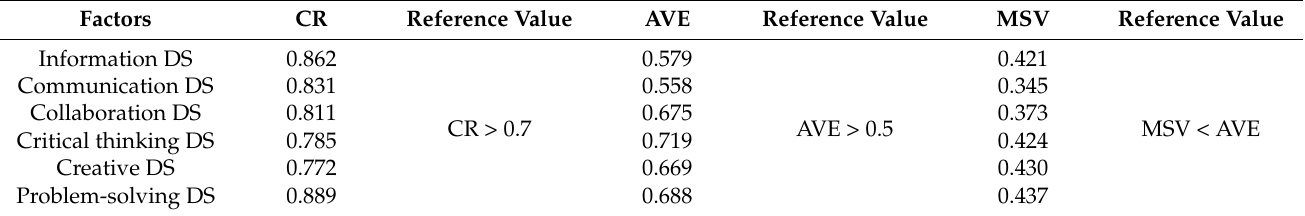
Table 4. Psychometric properties of the employed